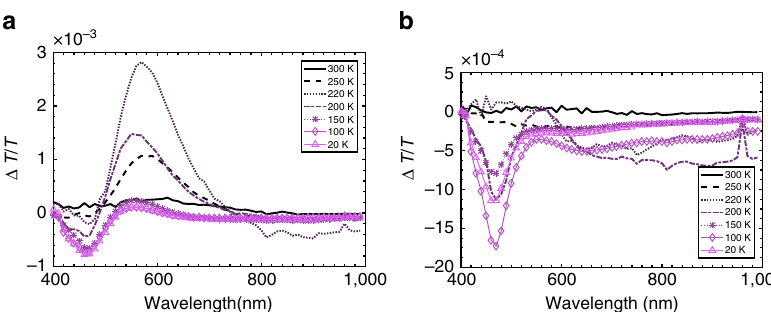
Figure 5 | Temperature-dependent photoinduced absorption of DPTZ-DBTO2 in polyethylene oxide. ( a ) The in-phase component of the PIA of DPTZ- DPTO2 in PEO over a temperature range from 300 to 20K. The resonance peak occurs near the T g at 220K. ( b ) The out-of-phase component of the PIA of DPTZ-DPTO2 in PEO. Between 200 and 220K there is a crossover between triplet dominated and CTdominated absorption highlighting the resonant point of the system.